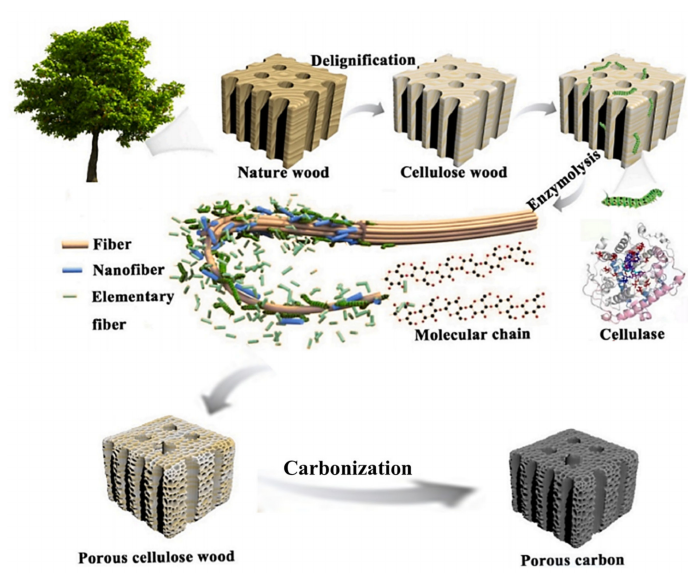
Figure 12. The schematic diagram of enzymatic mechanism [115].